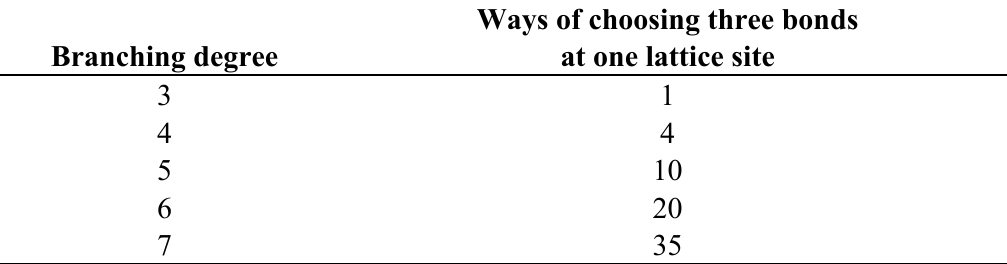
Table 3. Number of ways of choosing three bonds meeting at one lattice site up to branching degree of